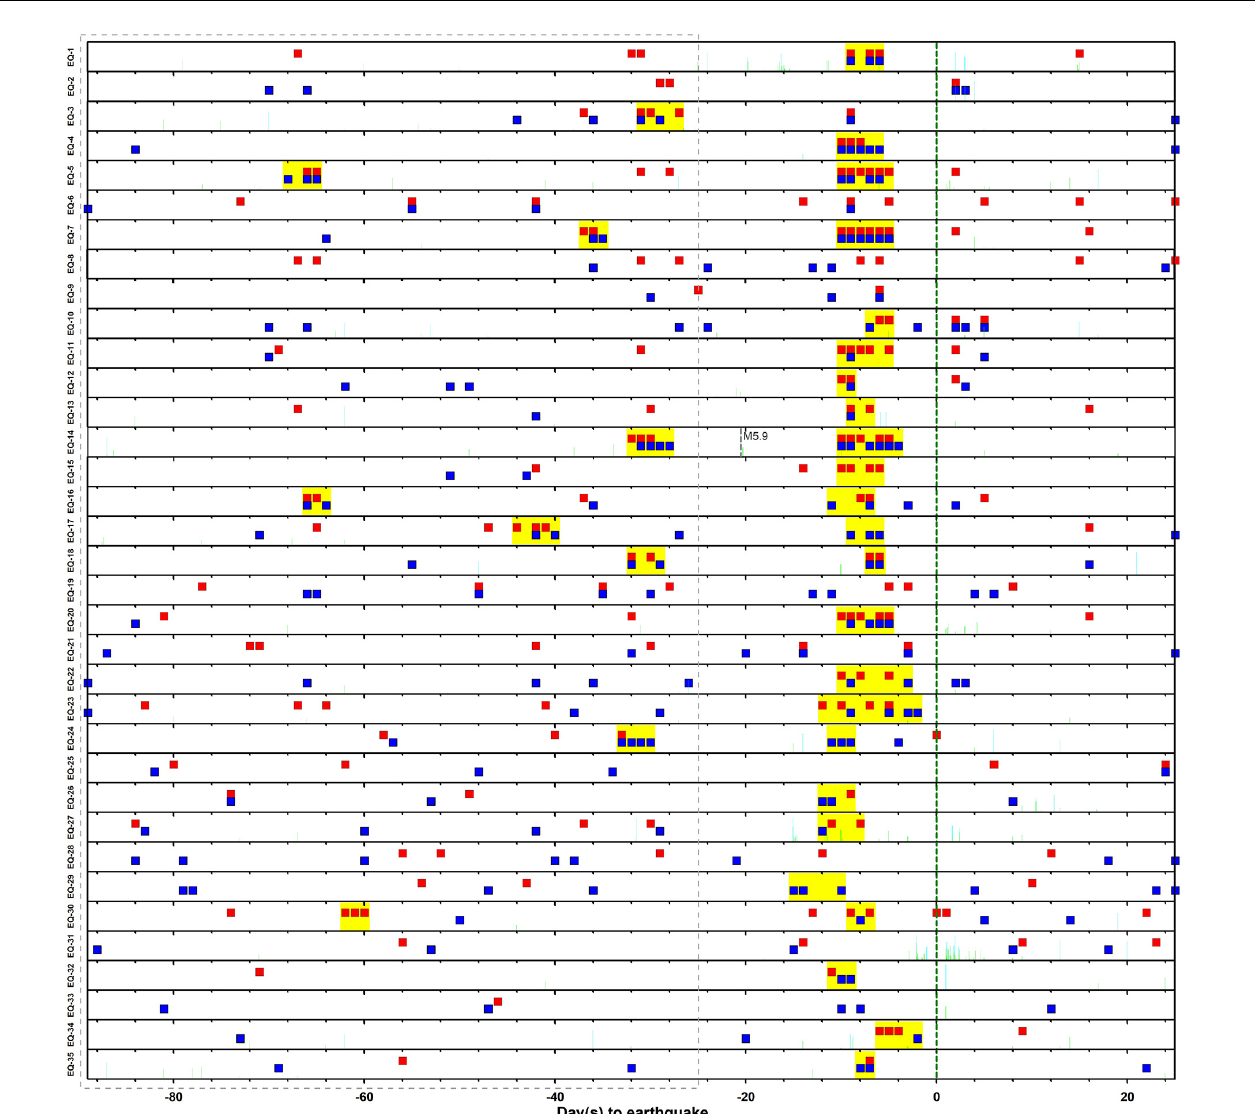
FIGURE 6 | Time-series of daily OLR E Index anomalies (EA) associated with the M ≥ 6 earthquakes from 2009 to 2019 around Taiwan for a confutation test over the same area. The red and blue squares indicate the daily EAs in the daytime and the nighttime, respectively, within 90 days before and 25 days after the earthquake. When at least three EAs are found within 4 days, this is referred to as a POEA (marked by the yellow highlighting). The occurrence of the strong earthquakes ( M ≥ 6) and the 2013/03/07 M5.9 earthquake are marked with the green and gray dashed lines, respectively. The occurrence of the earthquakes with the magnitude between 5–6 and 4–5 are denoted by light-blue line and light-green line, respectively. The unperturbed period without the strong earthquakes during 90–25 days before the event is marked by the gray dashed rectangle.